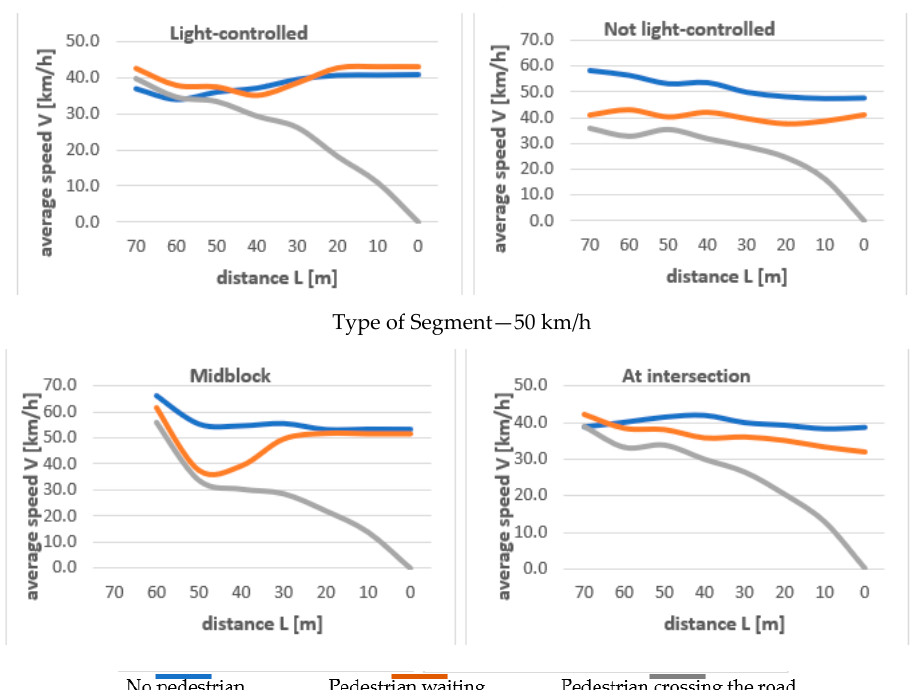
Figure 4. Vehicle speeds in pedestrian crossing areas—speed limit: 50 km/h.